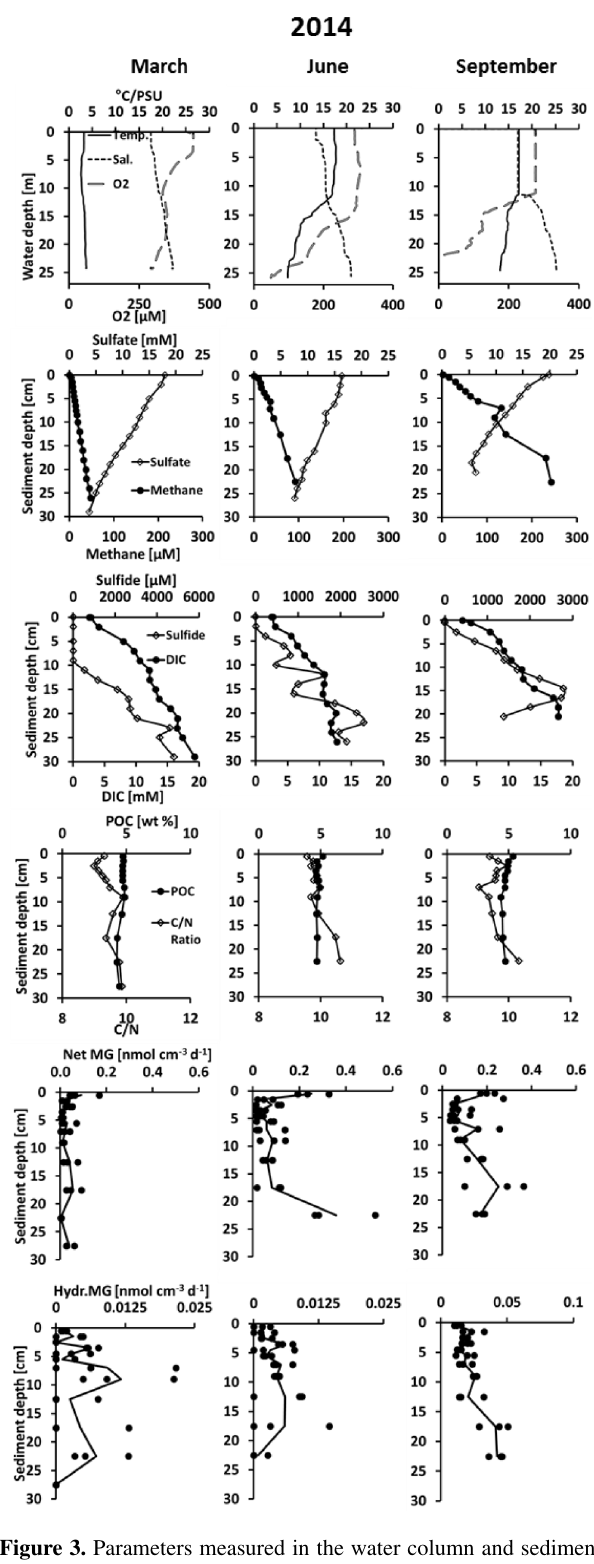
Figure 3. Parameters measured in the water column and sediment in the Eckernförde Bay in each sampling month in the year 2014. Net methanogenesis (MG) and hydrogenotrophic (hydr.) methano- genesis rates are shown in triplicates with mean (solid